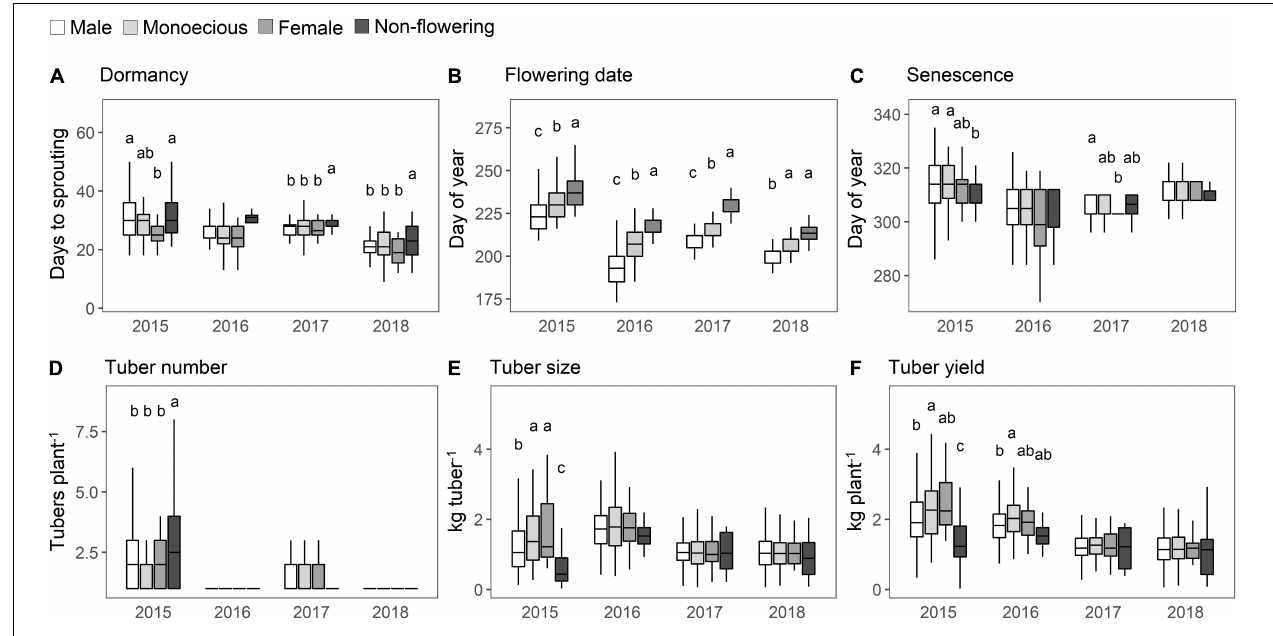
FIGURE 4 | Distribution of agronomic traits in each of the sex phenotypes. (A) Dormancy. (B) Flowering date. (C) Plant senescence. (D) Tuber number. (E) Tuber size. (F) Tuber yield. Trait values in the F 1 population are shown in the boxplot. The horizontal lines in the boxes are the median values. The height of the box is equal to the interquartile distance, indicating the distribution for 50% of the data. Approximately 99% of the data fall between the top and bottom of the lines extending from the box. Bars with different letters show significant difference at the P < 0.05. The monoecious phenotype includes both the first and second